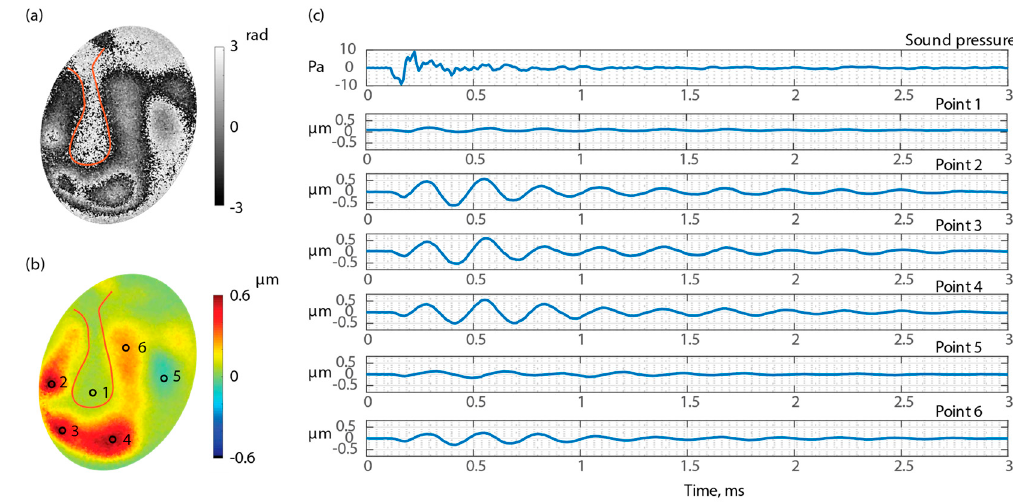
Figure 10. Waveforms of six points of the surface of the TM of TB3 when the middle-ear cavity is open.